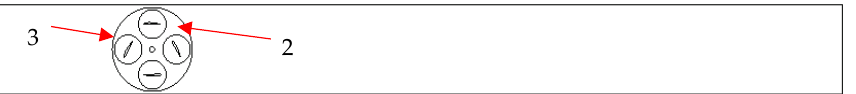
Figure 13. Cycloidal rotor fan stand : ( a ) during LDA measurement. ( b ) Marked with inlet and outlet measurement meshes. measurement meshes.